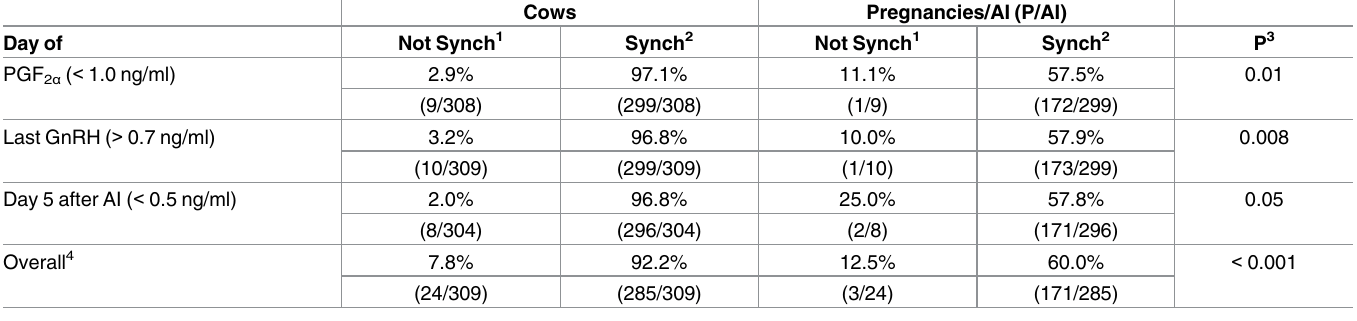
Table 4. Determination of synchronization based on progesterone (P4) concentrations. Cows were considered to not be synchronized if they had P4 < 1.0 ng/mL on Day of PGF 2 α , P4 > 0.7 ng/mL on Day of last GnRH, or P4 < 0.5 ng/mL on Day 5 after AI. Cows Pregnancies/AI (P/AI)